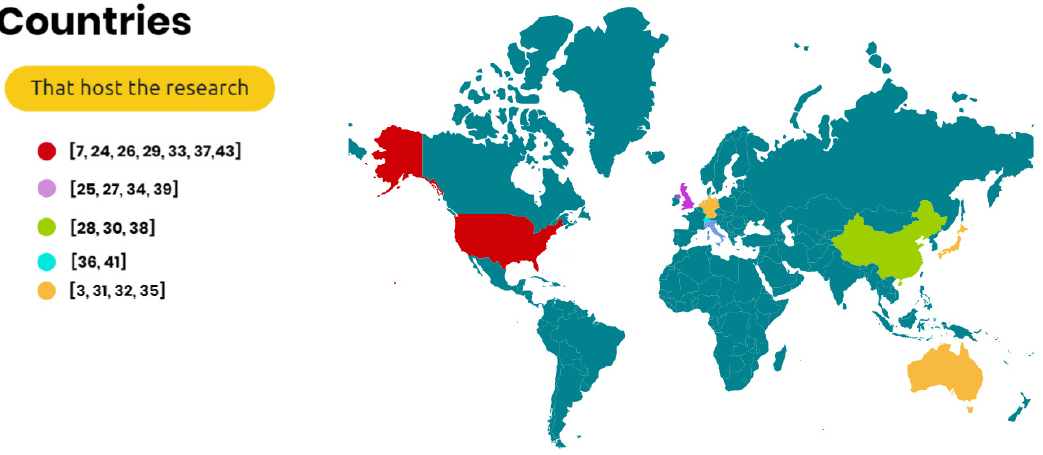
Figure 5. Locations of the studies focusing on Microsoft HoloLens [3,7,24–39,41,43]. Regarding operative settings, Microsoft HoloLens was used in various surgical spe- cialities, including anatomy pathology [25], otolaryngology surgery (head and neck) [27], cholangiography [22], and urological surgery [34], as well as in localization of perforated vessels/vascular localization system [26,39], for digital rectal examinations [28], in surgical 3D navigation [29], in shoulder arthroplasty [30], and in image-guided interventions [32] (Table 2). Moreover, this technology can be used in telepresence applications [39] or